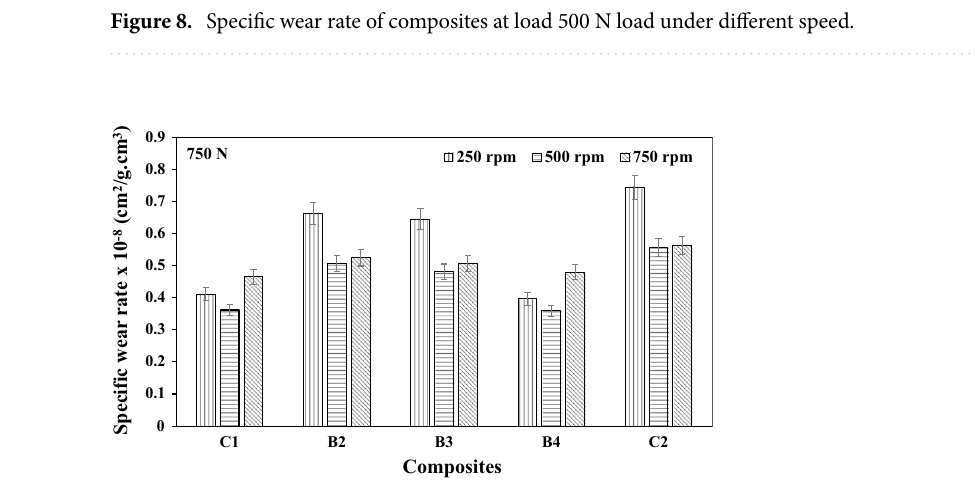
Figure 9. Specific wear rate of composites at load 750 N load under different speed.